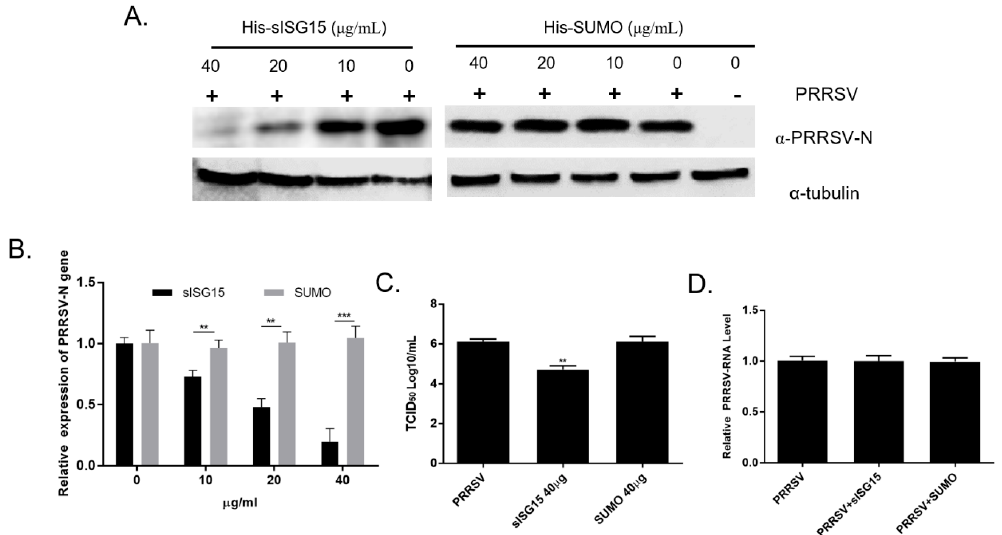
Figure 5. Extracellular ISG15 inhibits PRRSV infection in PAMs . ( A ) PAMs were treated with various dilutions of recombinant sISG15 for 12 h then infected with the PRRSV-SD16 strain at 1 MOI. After 24 h, PAMs were harvested for Western blot analysis then blots were probed with homemade anti- PRRSV-N Mab-6D10 to monitor replication of PRRSV. PAMs treated with recombinant SUMO protein were included as a control. ( B ) PAMs were first treated with either sISG15 or SUMO protein for 12 h then were infected with PRRSV-SD16 strain at 1 MOI. After 24 h of infection, PAMs were harvested for qPCR evaluation of mRNA levels corresponding to PRRSV-N proteins. All experiments were repeated at least three times. Significant differences between indicated groups are marked by ** for p < 0.01 or *** for p < 0.01. ( C ) Cell culture supernatants from sISG15-treated or SUMO-treated PAMs followed by PRRSV-SD16 infection were titrated to quantify numbers of infectious virus particles in MARC-145 cells. All experiments were repeated at least three times. Significant differences between indicated groups are marked by ** for p < 0.01. ( D ) PAMs were pre-incubated with the 40 μ g of either sISG15 protein or SUMO protein for 24 h at 37 °C or left untreated (control), followed by pre- chilling at 4 °C for 30 min prior to PRRSV inoculation. The PRRSV-JXA1 strain was used to inoculate the PAMs at 0.1 MOI at 4 °C for 1 h to avoid triggering of endocytosis. After washing cells using